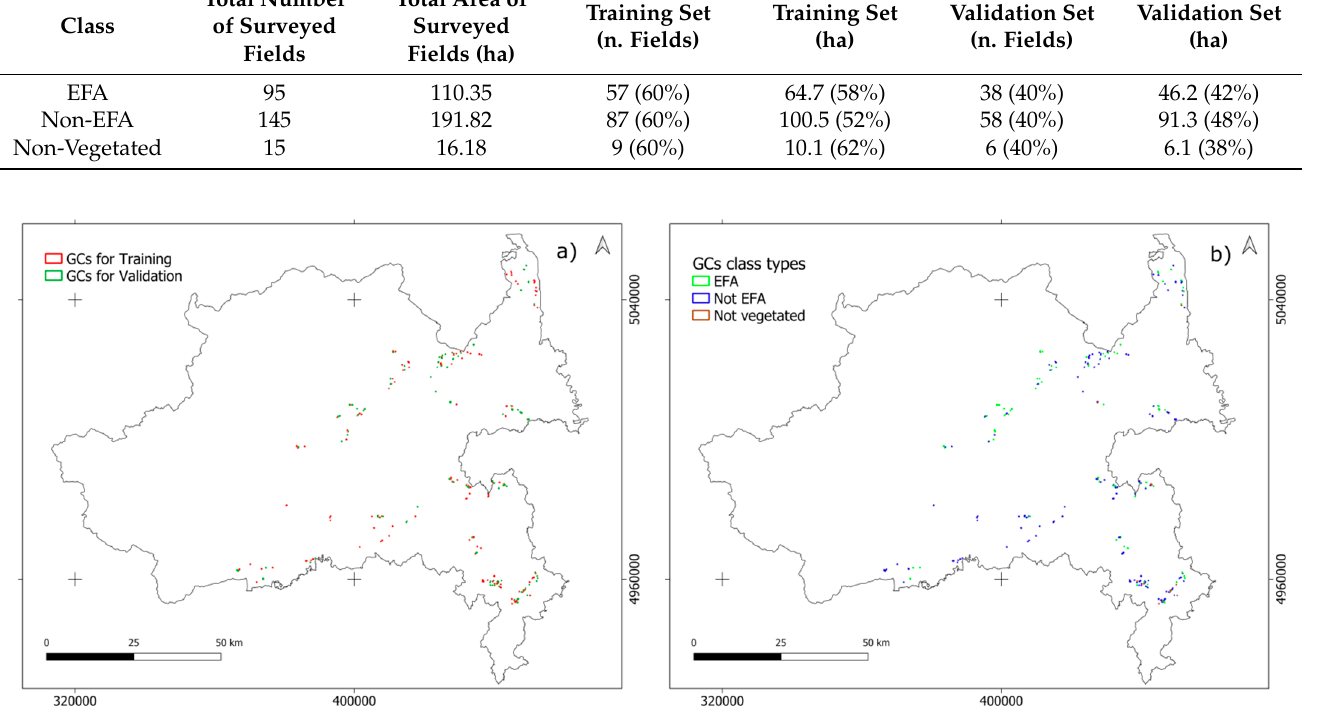
Figure 2. ( a ) Spatial distribution of the GCs used in the training and validation phase; ( b ) Spatial distribution of the GCs class type. (Reference system is WGS84/UTM 32N, EPSG: 32632).